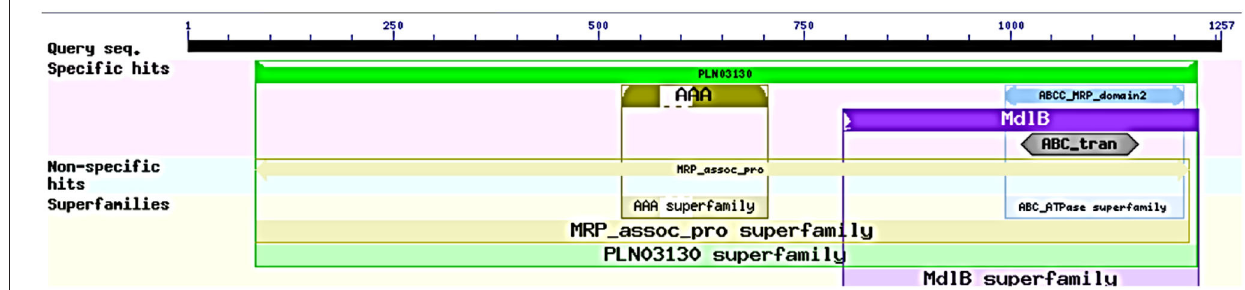
FIGURE 2 | Domain analysis of abct 31 analyzed by CDD program.